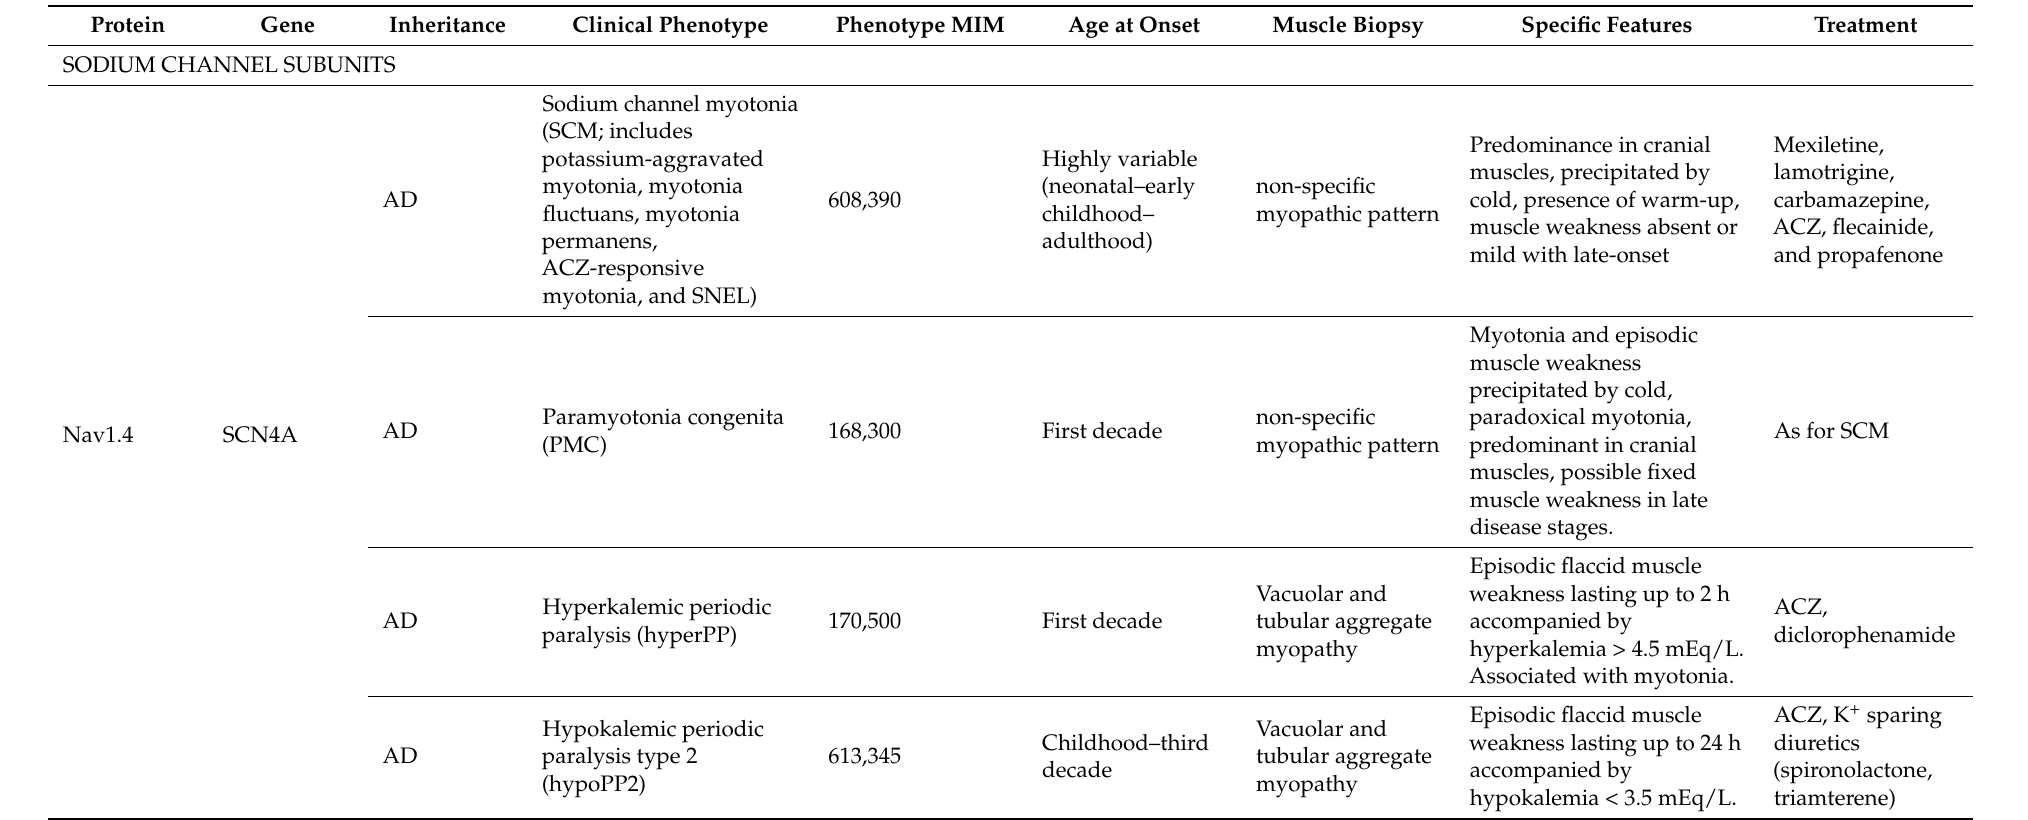
Table 1. Ion channels gene mutations and related clinical muscular